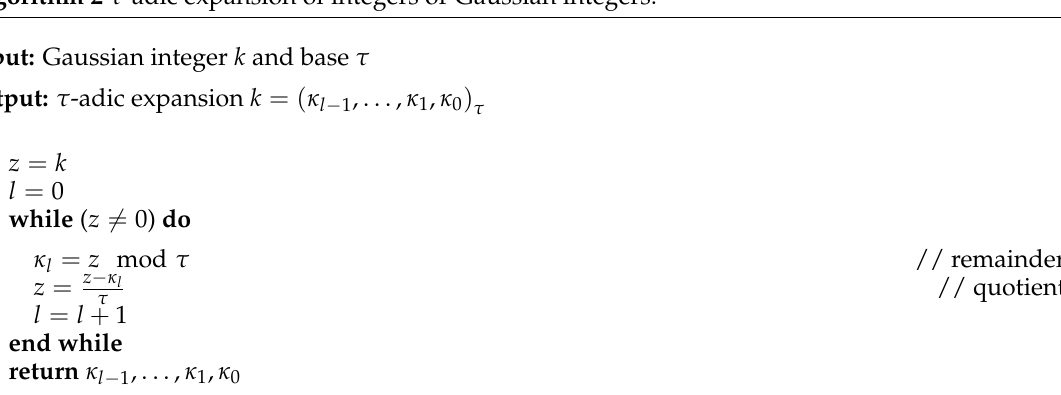
Algorithm 2 τ -adic expansion of integers or Gaussian integers.